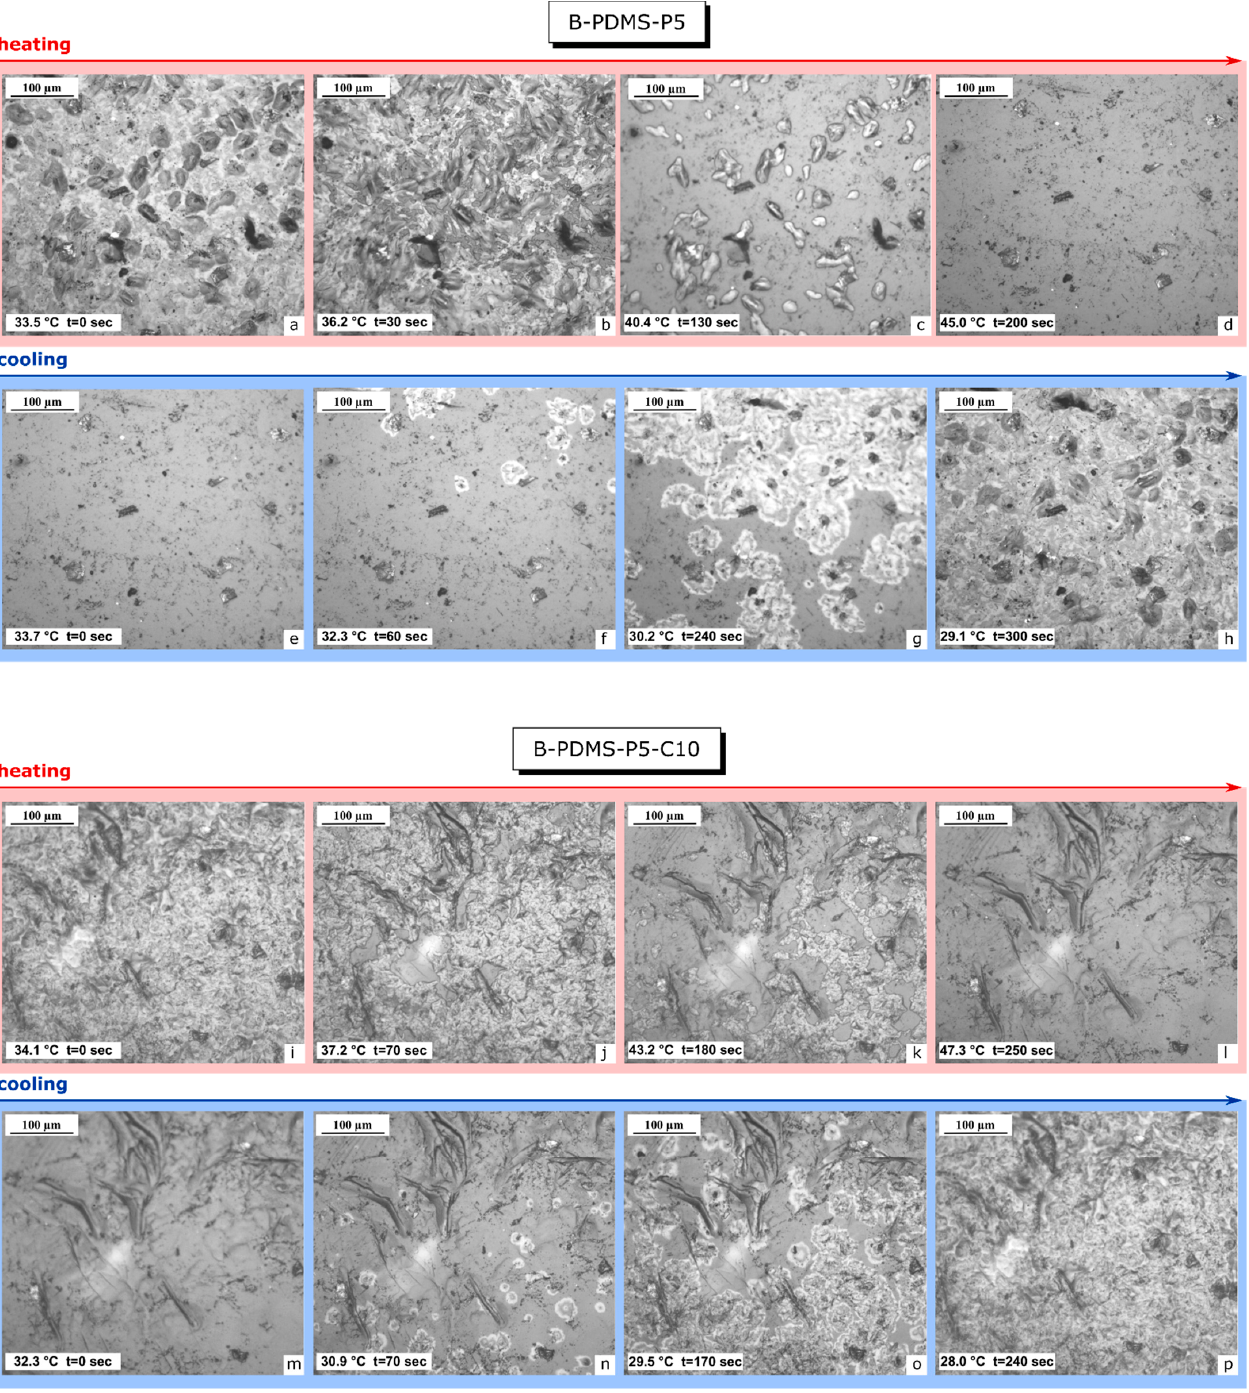
Figure 4. Light optical microscope micrographs of the bulk samples PDMS-P5 ( a – h ) and PDMS-P5- C10 ( i – p ) during heating and